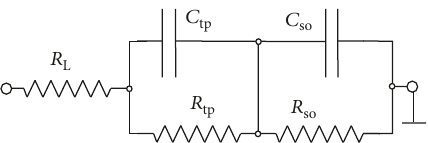
Figure 1: Equivalent circuit for metal-Ta 2 O 5 /SiO 2 –Si structures [17].